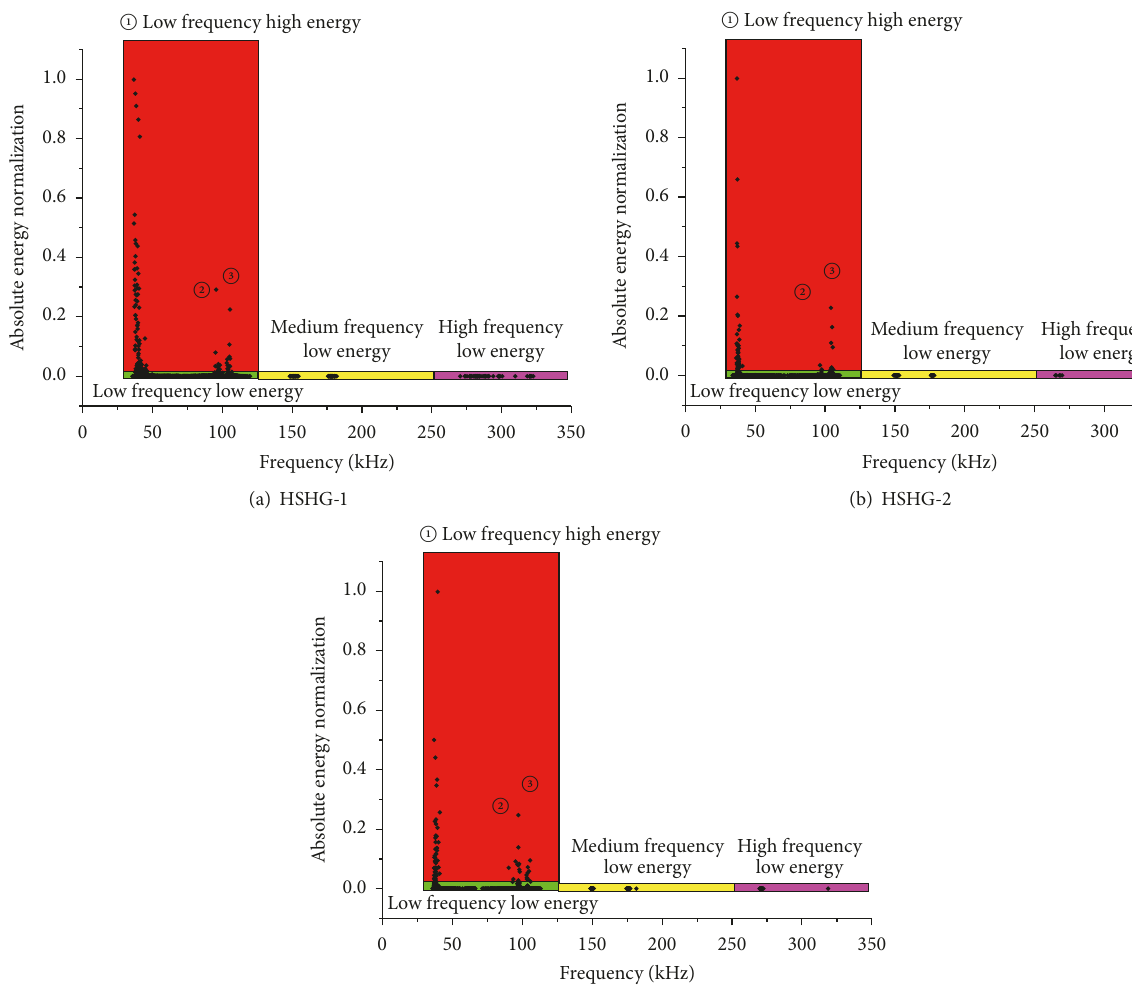
Figure 6: The correlation diagram of dominant-frequency and energy in the process of granite fracture.